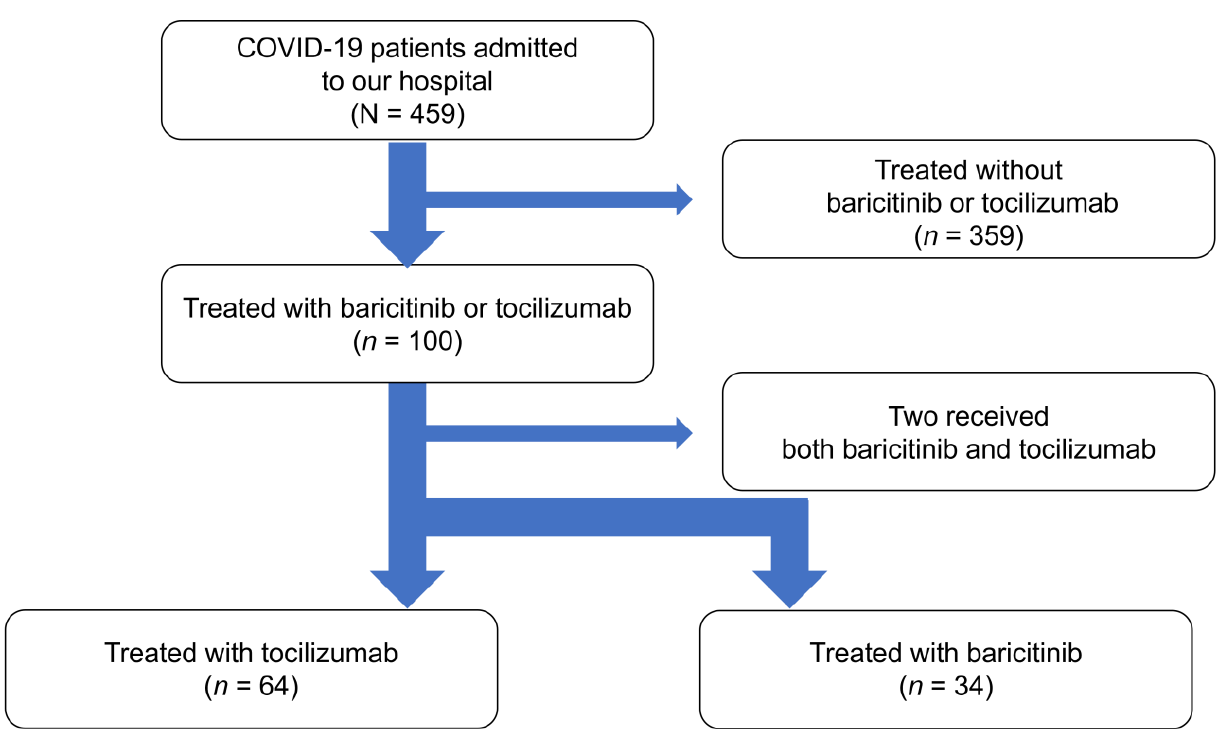
Figure 1. Flow chart of patients with coronavirus disease 2019 (COVID-19) in the tocilizumab and baricitinib groups. Coronavirus disease 2019, COVID-19.